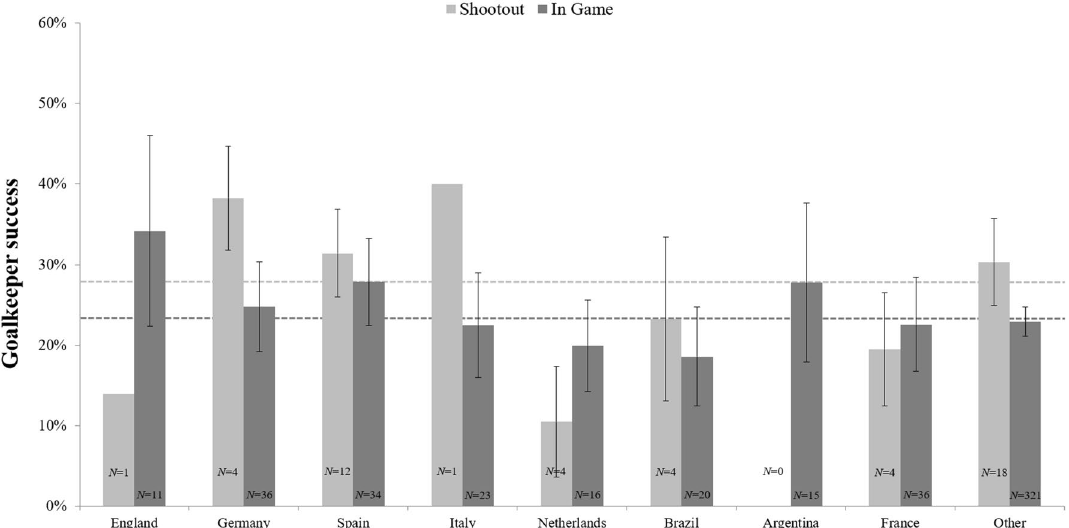
Figure 2. Mean percentages of the goalkeeper success ratios for penalty kicks faced during Champions League and Europa League matches as a function of goalkeeper nationality and type of penalty kick. The N ’s refer to the number of goalkeepers analyzed for each nation (426 of 1669 penalty kicks were missed against 515 different goalkeepers in the analyzed time periods). Error bars represent standard errors of the